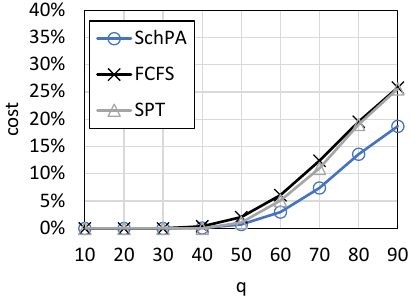
Figure 9. Cost loss after deadline